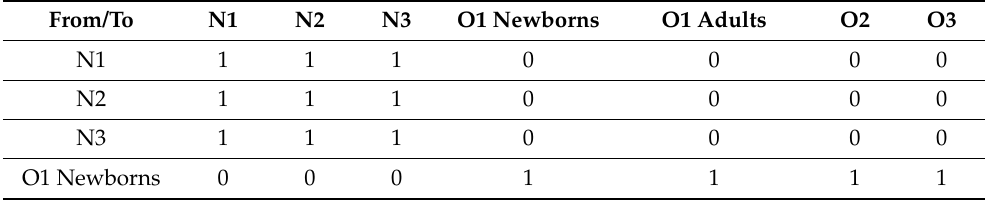
Table A2. Skill matrix for Models 2 and 3 for the Perinatology Care System, Configuration 1.